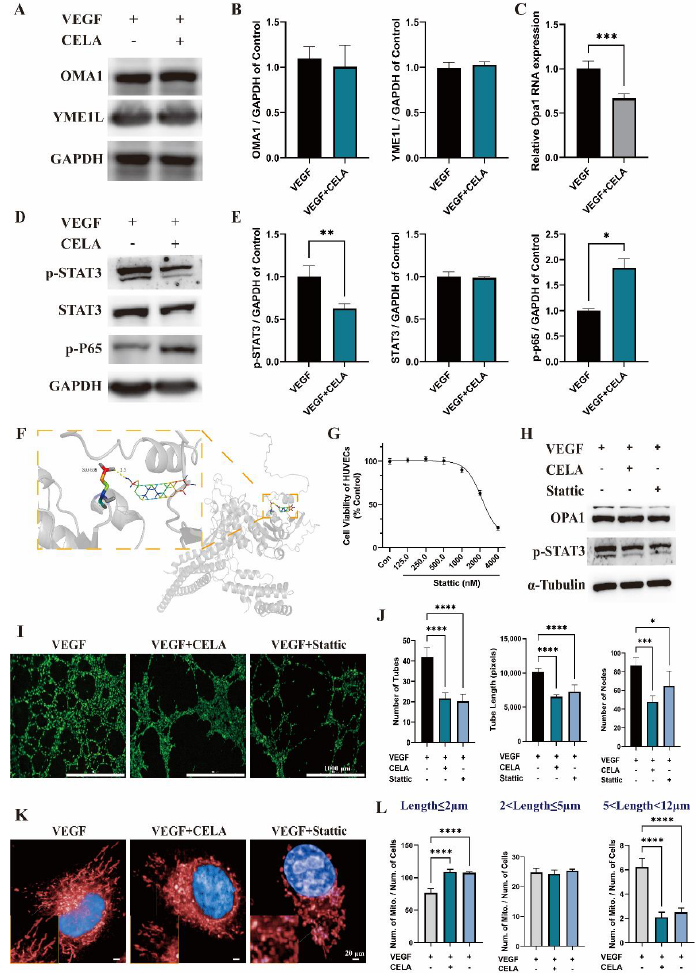
Figure 5. Celastrol downregulates OPA1 by triggering the phosphorylation of STAT3. ( A , B ) The effects of celastrol on protein levels of OMA1 and YME1L. ( C ) The effects of celastrol on OPA1 mRNA. ( D , E ) The effects of celastrol on protein levels of p-STAT3, STAT3, p-P65, and GAPDH. ( F ) Schematic diagram of binding between celastrol and STAT3 protein, protein is shown in the gray cartoon, the ligand is represented by rainbow sticks. ( G ) Cell viability of HUVECs after 24 h stattic treatment. ( H ) The effects of stattic on protein levels of OPA1, p-STAT3, and α -Tubulin. ( I , J ) The effects of stattic on the nodes of tubes, the number of tubes, and tube length in HUVECs. ( K , L ) The effects of stattic on mitochondrial length in HUVECs evaluated by high-content screening. * p < 0.05, ** p < 0.01, *** p < 0.001, **** p <